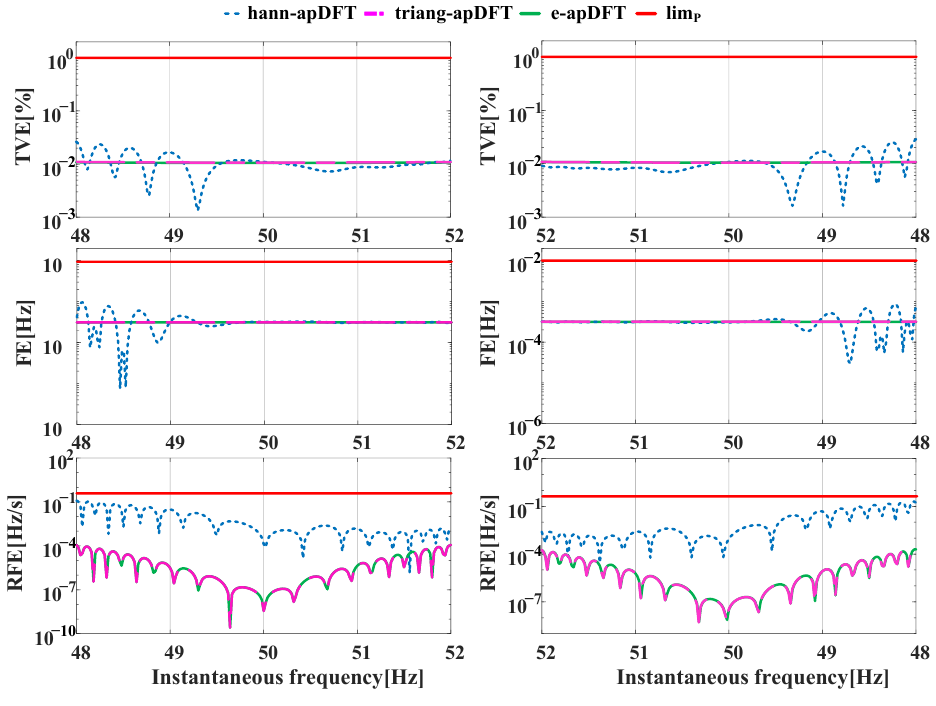
Figure 11. Frequency ramp test.